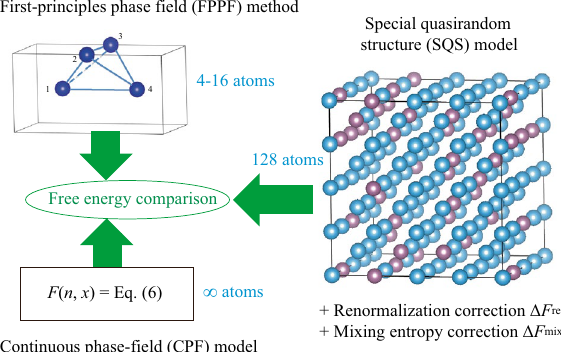
Figure 1. Workflow to compare the free energies evaluated by the FPPF method, the CPF model, and the SQS